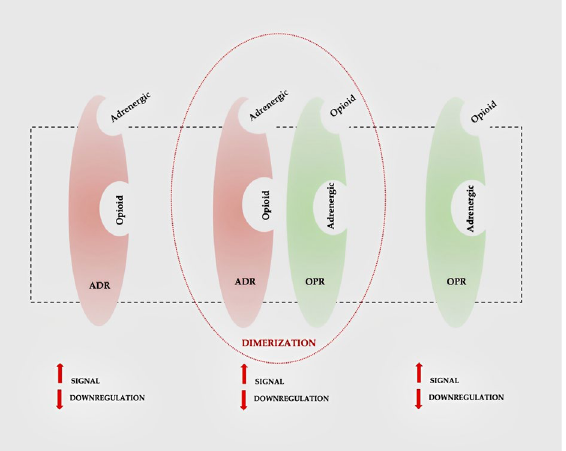
Figure 2. Opioid and adrenergic receptors have different sites to which both adrenergic and opioid drugs can bind. In the presence of both the ligands, not only the single receptorial conformation changes but also receptorial dimerization occurs, leading to a signal transmission increase and a receptorial downregulation reduction; this results in a synergic interaction between opioid and adrenergic drugs.